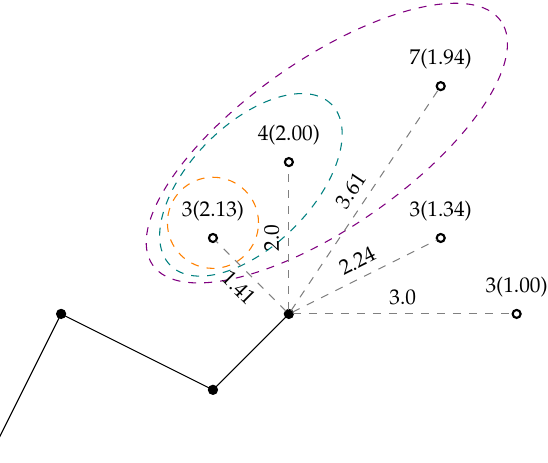
Figure 4. An example of a single decision cycle in the greedy heuristic. Here, the algorithm has to decide between the nodes connected with grey dashed lines. The node scores are written above with SDR in parentheses, and the arc lengths are shown next to the arcs. The coloured ellipses showcase the RCL list for 100%, 80% and 60%,